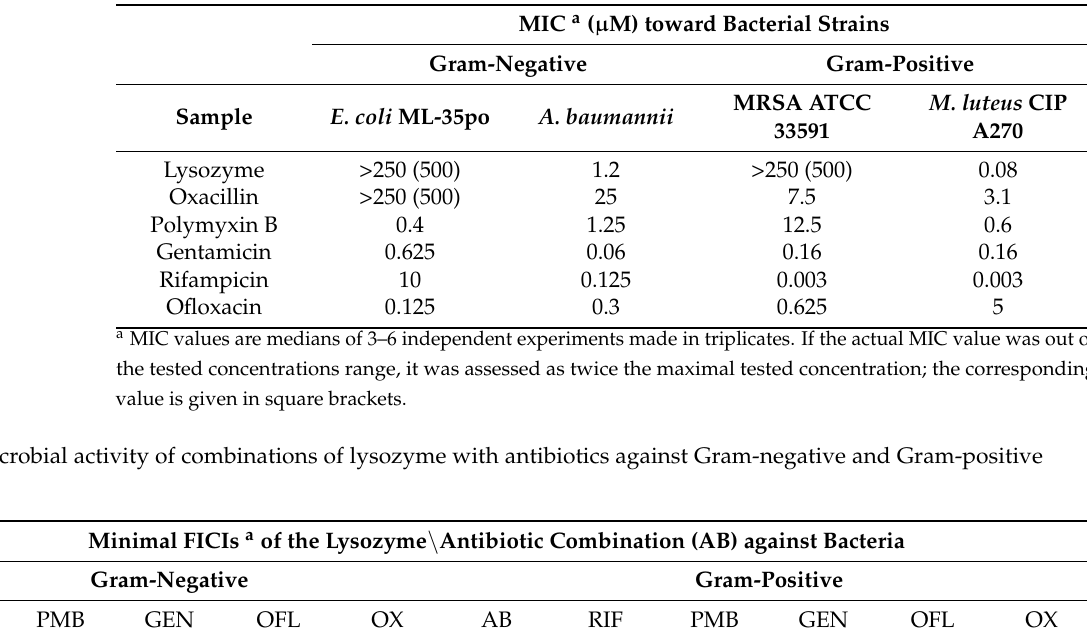
Table 3. Antimicrobial activity of individual fractions of lysozyme and antibiotics against Gram- negative and Gram-positive bacteria.